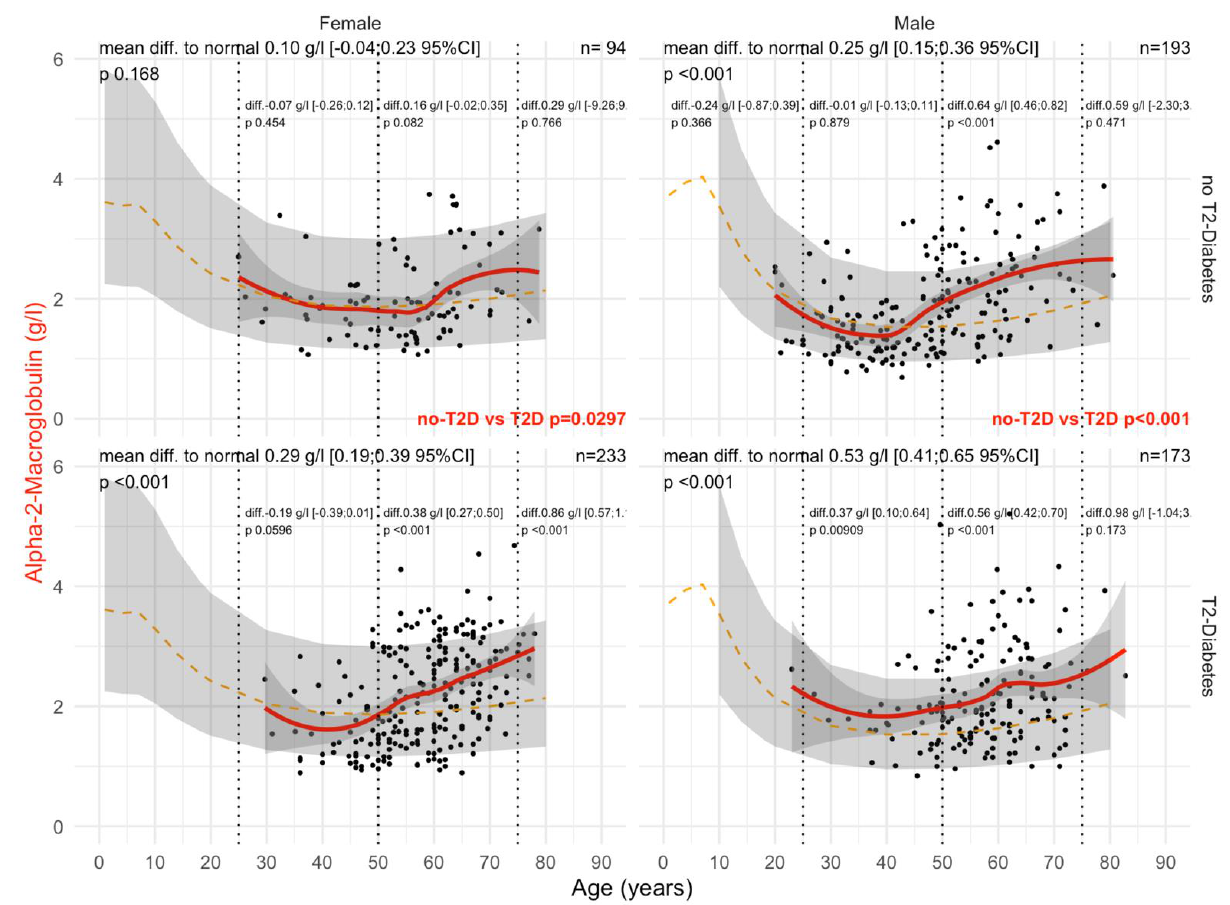
Figure 4. A2M levels in “NAFLD-Biopsy” patients with significant steatosis stages S2S3. Impact of T2DM on A2M concentration in NAFD-biopsied patients with significant steatosis S2S3 (n = 693). Normal serum means values according to age and sex (dashed–orange lines), with 95% confidence intervals (light-gray ribbon). Three vertical–dotted lines mark the four age groups (before 25, between 25 and 50, between 50 and 75, and above 75 years old). Each point is a patient’s protein value. The red curve is a Loess regression of the median of A2M values, along with its 95% confidence interval (darker gray). For each age group, the mean difference (%95CI) between patient protein value and the expected normal value (for age and sex) with its significance p -value is displayed at the top of the figure. The significance between the non-T2DM and T2DM patients is displayed in red between the 2 panels.